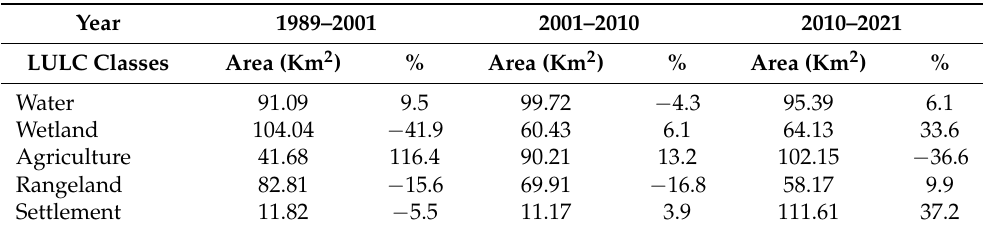
Table 3. LULC changes from 1989 – 2021 in area and percentage.